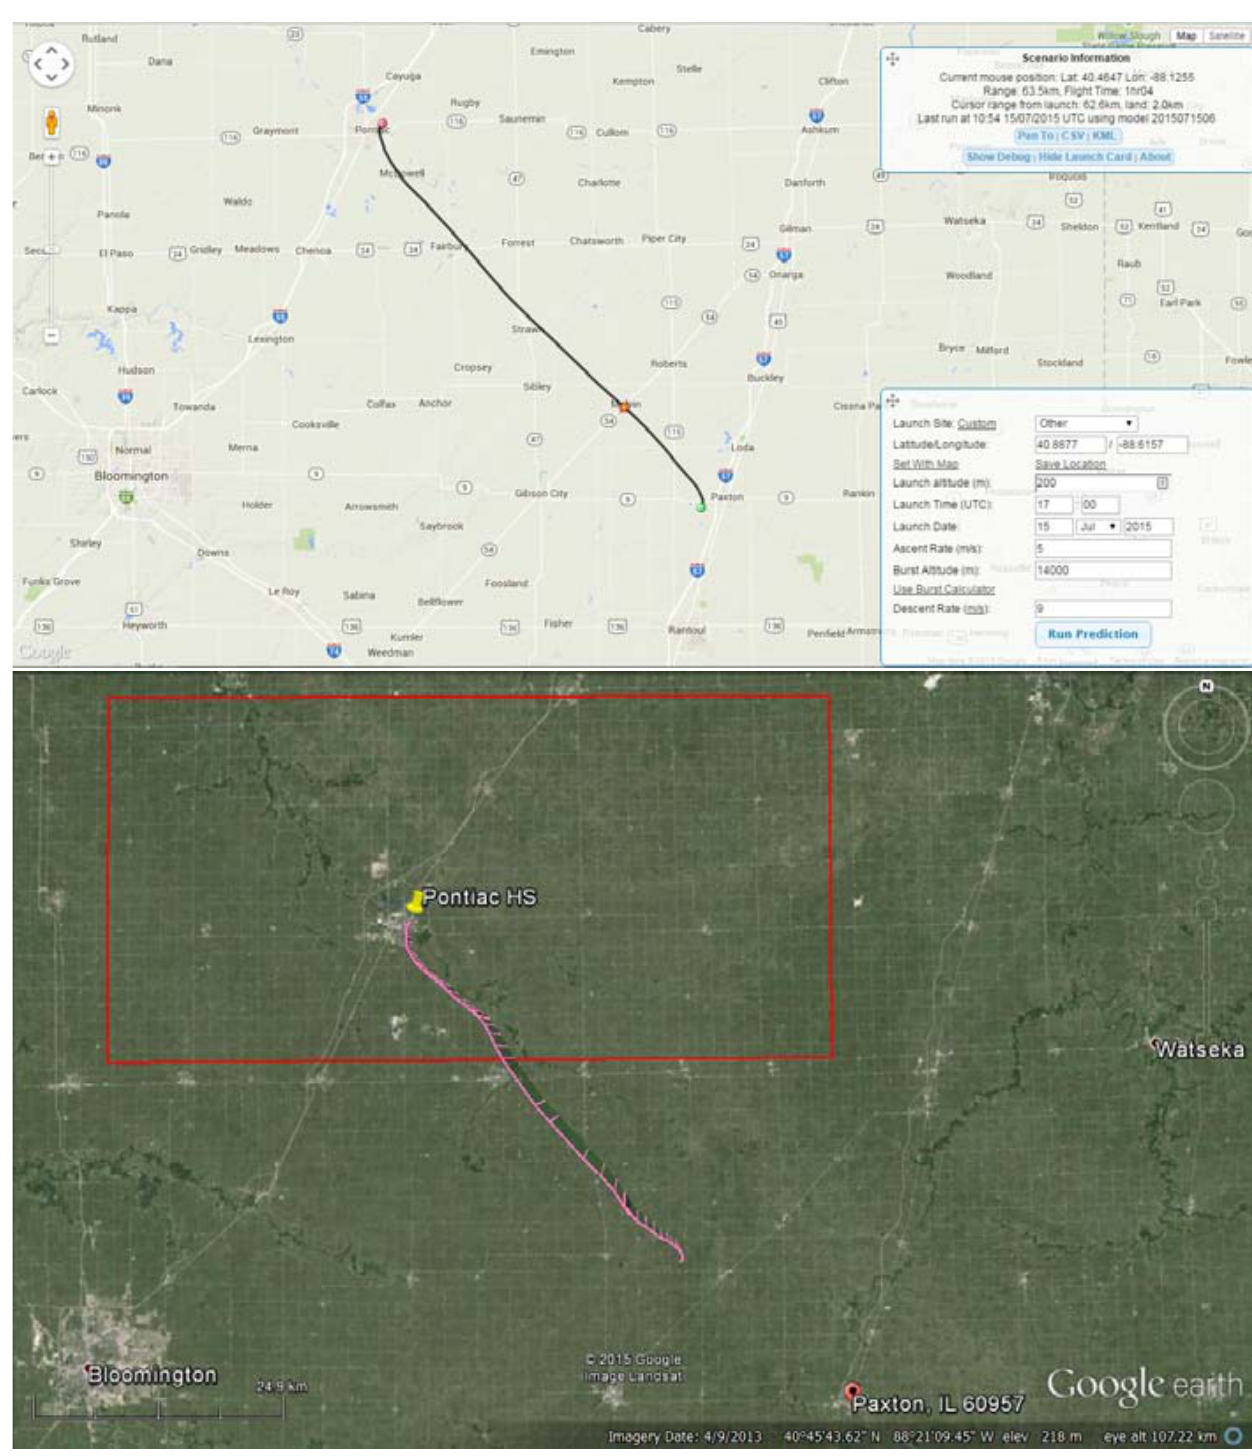
Figure 3. Comparison of actual (bottom) and predicted (top) flight paths on 15 July 2015. Flights were predicted prior to launch using NOAA GFS (National Oceanic and Atmospheric Administration Global Forecast System) models. The actual flight path was tracked using a Stratostar command module. The red box in the bottom panel indicates the bounding box for the NDVI